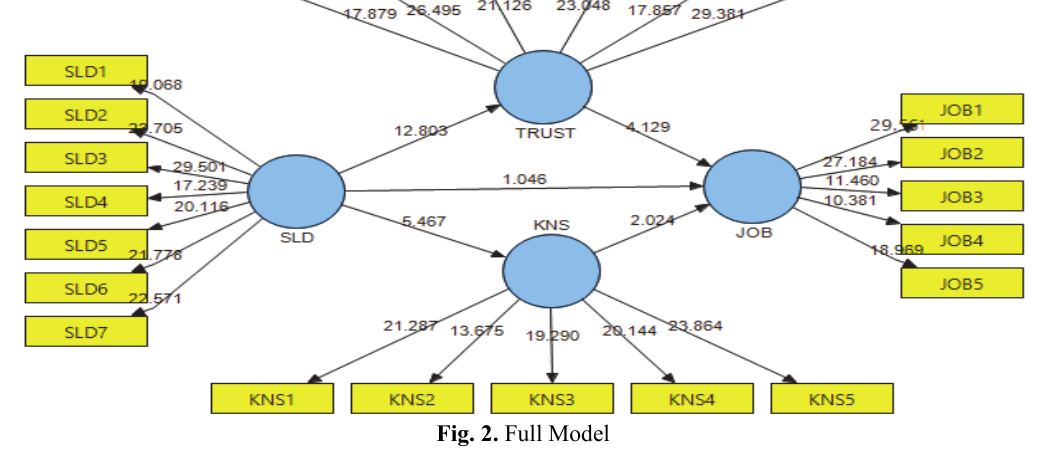
Total effects and path